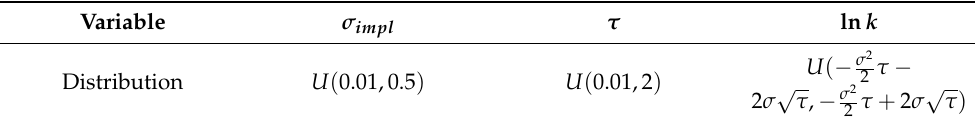
Table 1. Variable ranges involved in generating the virtual test data. U ( a , b ) is the uniform distribu- tion on ( a , b )